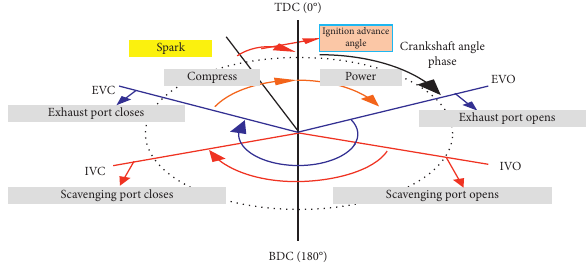
Figure 1: Main parts of the two-stroke aeroengine. Table 1: Specifications of DLE170 engine.